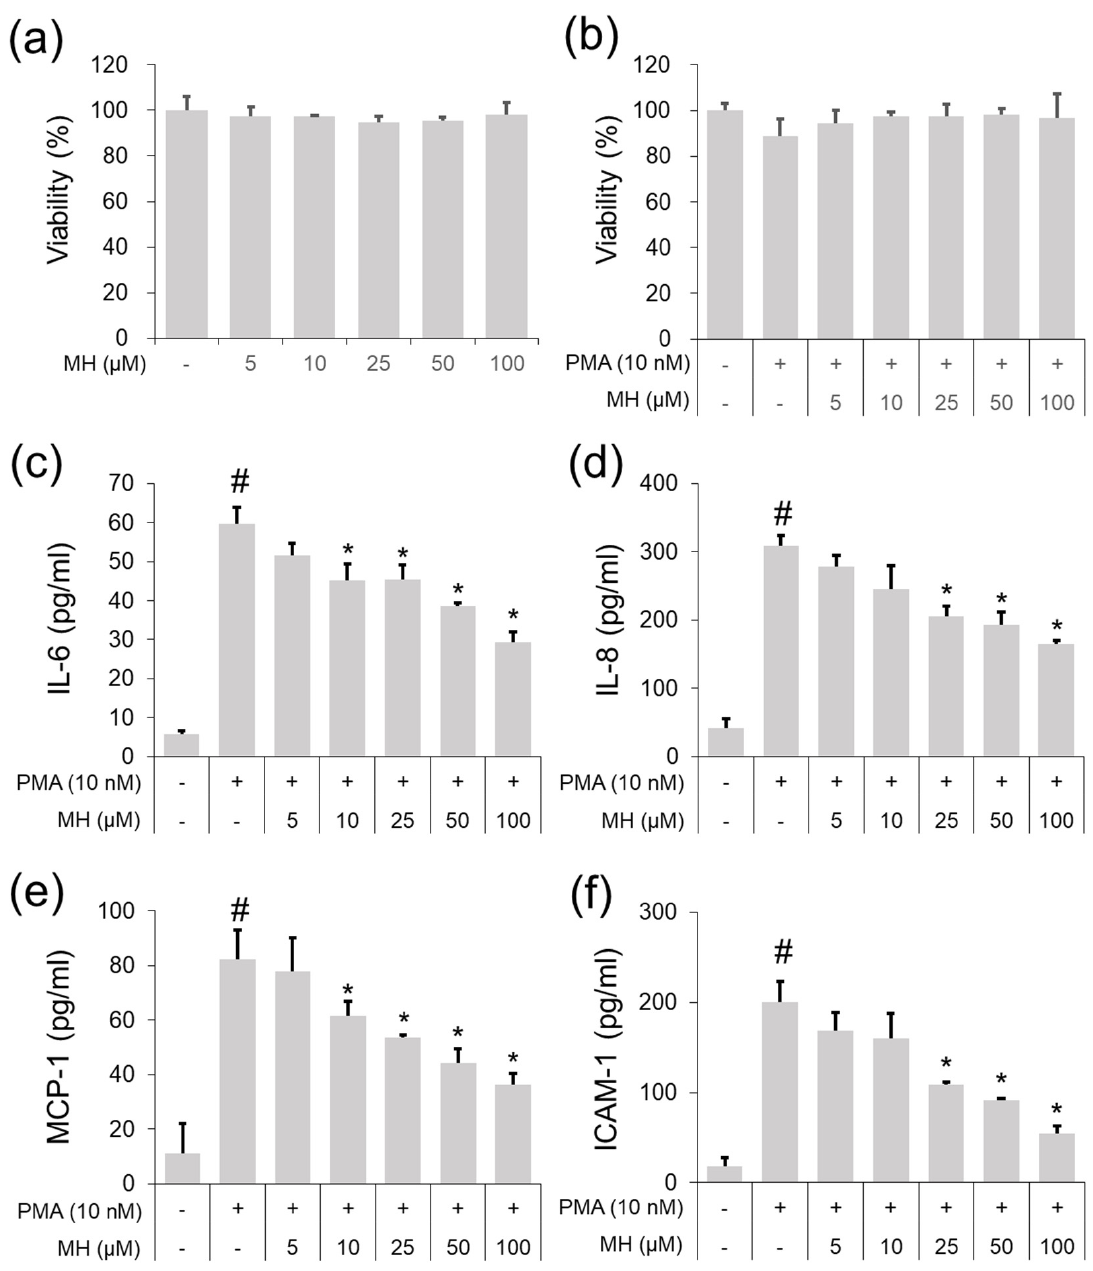
Figure 1. Effects of MH on secretion of cytokines, chemokines, and adhesion molecules in PMA − stimulated A549 cells. Cells were treated with MH (5, 10, 25, 50, and 100 μ M) 1 h prior to incubation with 10 nM PMA for 18 h. ( a , b ) Cell viability was evaluated using CytoX assay. ( c – f ) The levels of IL − 6, IL − 8, MCP − 1, and ICAM − 1 were detected using ELISA kits. Data are expressed as the mean ± SD (n = 3) ( # p < 0.05 for comparison with control; * p < 0.05 for comparison with 10 nM PMA).